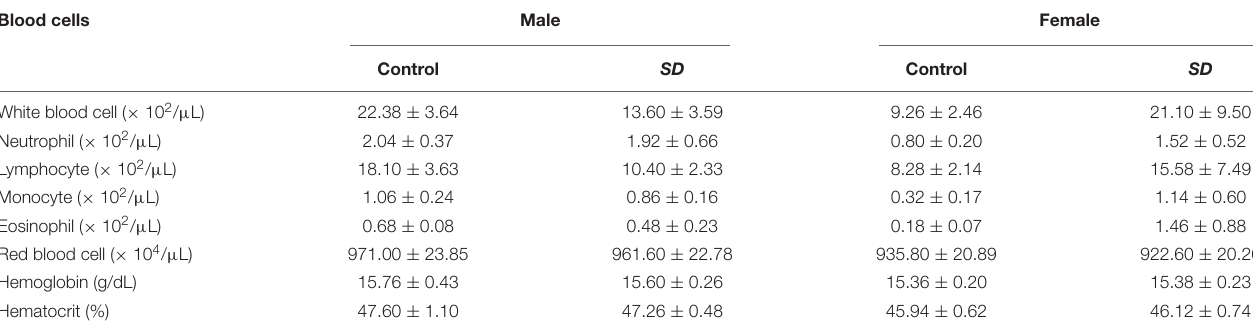
TABLE 4 | Hematological parameters of mice after administration of mixed diet including 1% (w/w) NRG SD or 1% (w/w) base materials (control) for 28 days. Blood